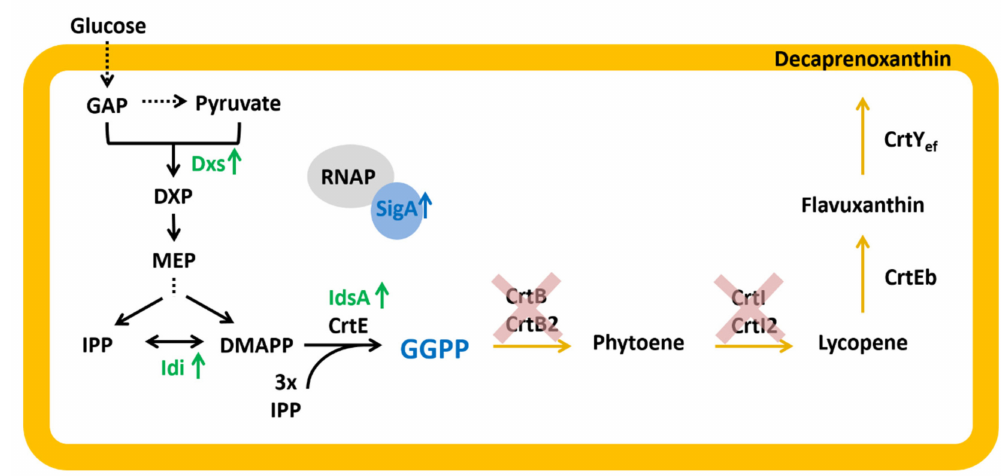
Figure 5. GGPP and decaprenoxanthin biosynthesis pathway in C. glutamicum . GAP: glyceraldehyde 3-phosphate, DXP: 1-deoxy-1-xylulose-5-phosphate; MEP: methylerythritol phosphate; IPP: